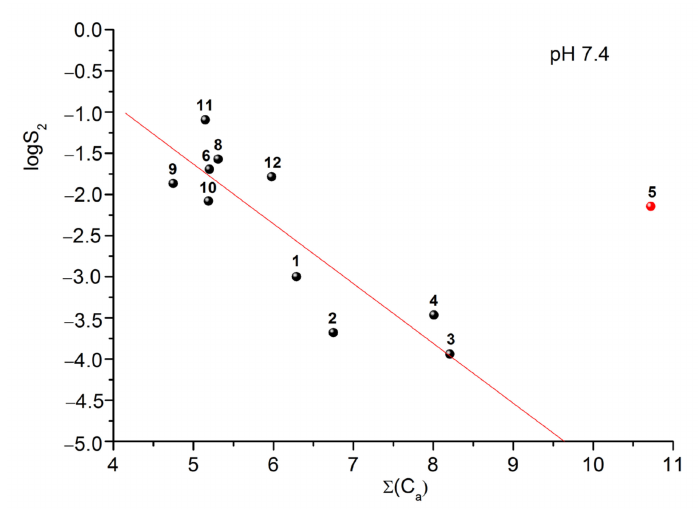
) versus Σ ( C ) descriptor. (compound numbering corre- d / α 2